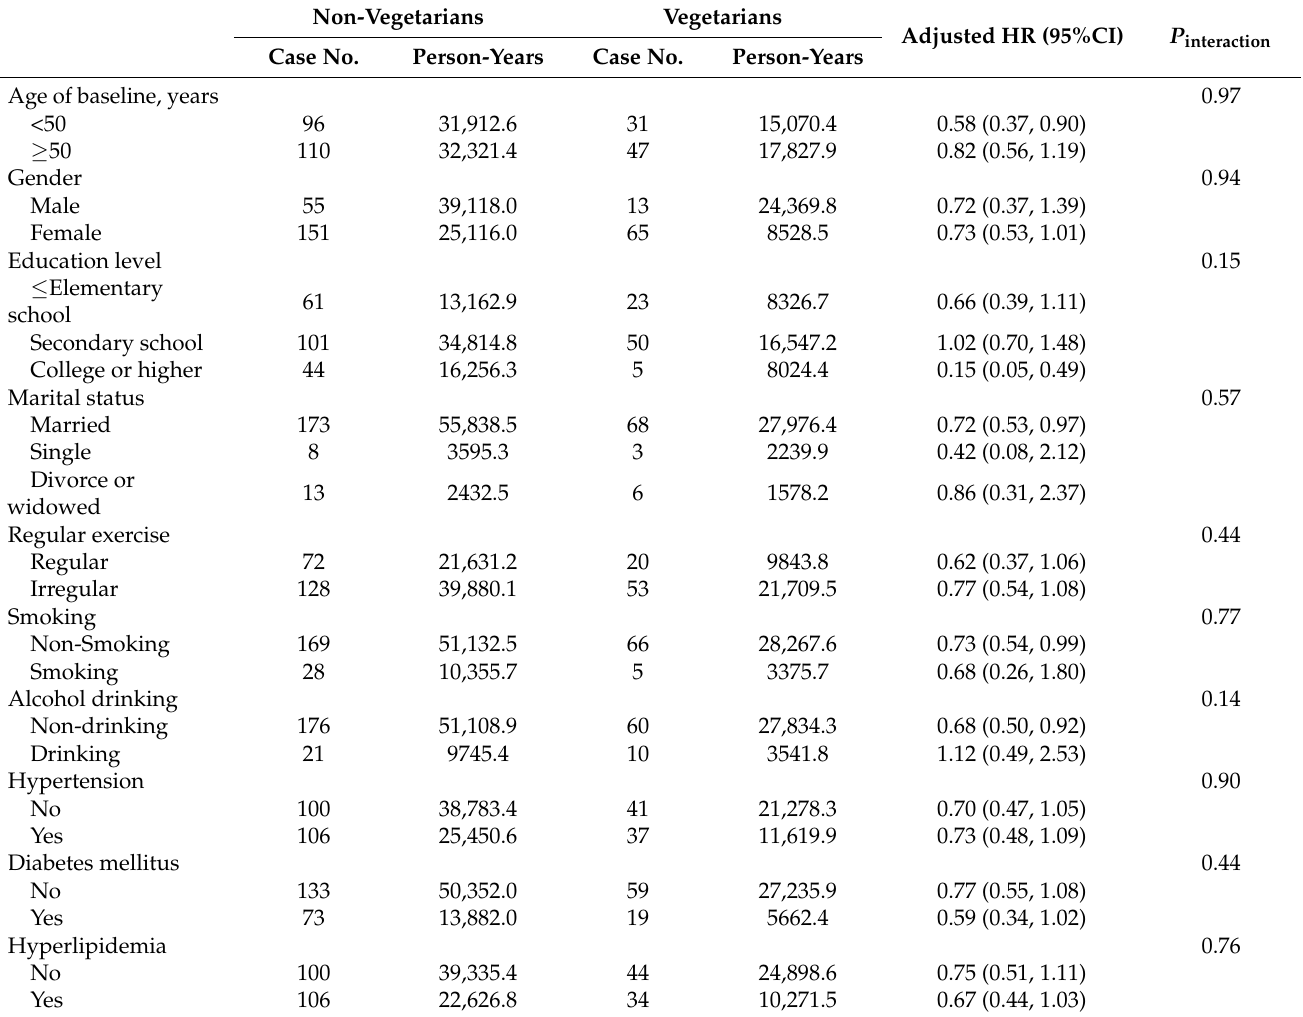
Adjusted HR (95%CI) P interaction